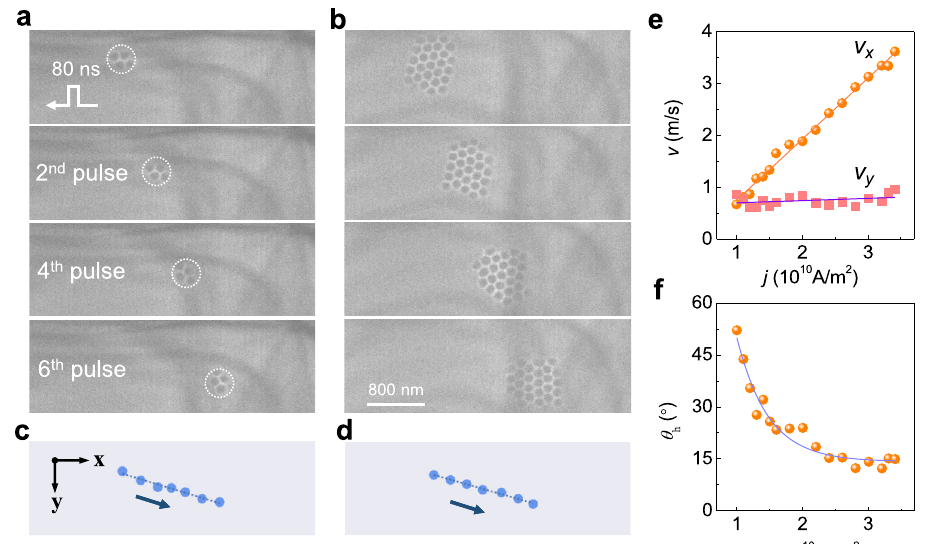
Fig. 4 Spin transfer torque induced skyrmion clusters motion. The sequences of images in ( a ) and ( b ) show the positions of skyrmions after applying the negative current pulses where the duration of each pulse is 80 ns, and the current density is (cid:1) 2 ´ 10 10 A (cid:3) m (cid:1) 2 . a A skyrmion cluster with N s ¼ 4. b A skyrmion cluster with N s ¼ 26. The corresponding trajectories of the skyrmion center are shown in ( c and d ) and fi t well to straight lines. The negative pulses lead to positive displacements in the + x direction independent of the skyrmion number. The skyrmion Hall angle characterizes the nonzero transverse motion in the + y direction θ h which depends on the skyrmion number and is unrelated to the current direction. The amplitude of the external fi eld B is 117 mT. e The skyrmion velocity as a function of the current density. The x -component velocity scales linearly with the current density. f The skyrmion Hall angle θ h as a function of current density.